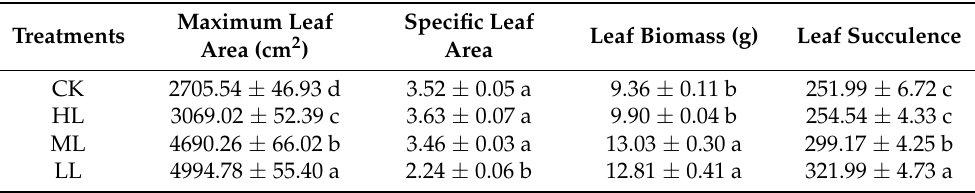
Table 2. The leaf area, specific leaf area, leaf succulence and leaf biomass of J. regia f. luodianense seedlings treated with different light